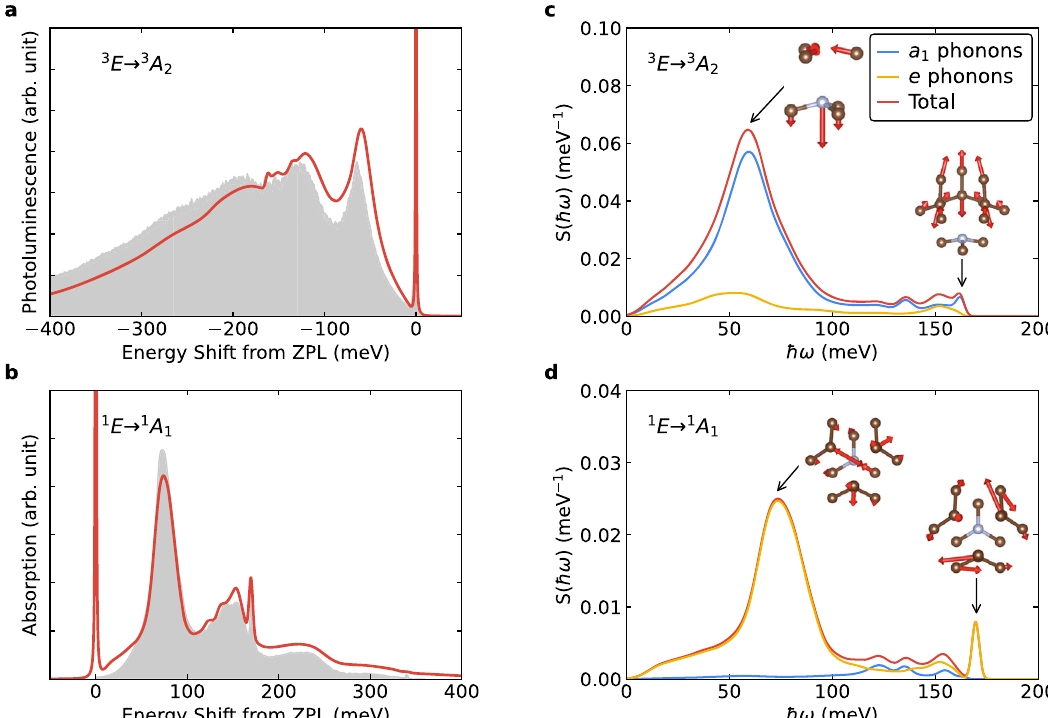
Fig. 5 Optical spectra and spectral densities. a Photoluminescence (PL) line shapes of the 3 E → 3 A 2 transition and b absorption line shapes of the 1 E → 1 A 1 transition. Red lines are theoretical results while the gray area represents experimental spectra from refs. 17,41 . Spectral densities S ( ℏ ω ) of the 3 E → 3 A 2 ( c ) and the 1 E → 1 A 1 transitions ( d ). Contributions from a 1 and e type phonon modes are shown as blue and yellow lines, respectively. The quasi-local (local) a 1 mode at 60 meV (162 meV) of the 3 A 2 state that strongly couples with the 3 E → 3 A 2 transition is shown in the inset of c . The quasi-local (local) e mode at 73 meV (170 meV) of the 1 A 1 state that strongly couples with the 1 E → 1 A 1 transition is shown in the inset of d . Results reported here are based on phonons computed at the PBE level of theory and optimized geometries computed at the DDH level of theory, and are extrapolated to the dilute limit, approximated by a (12 × 12 × 12) supercell with 13,824 atomic sites. A comparison of results obtained using different functionals is given in Supplementary Note